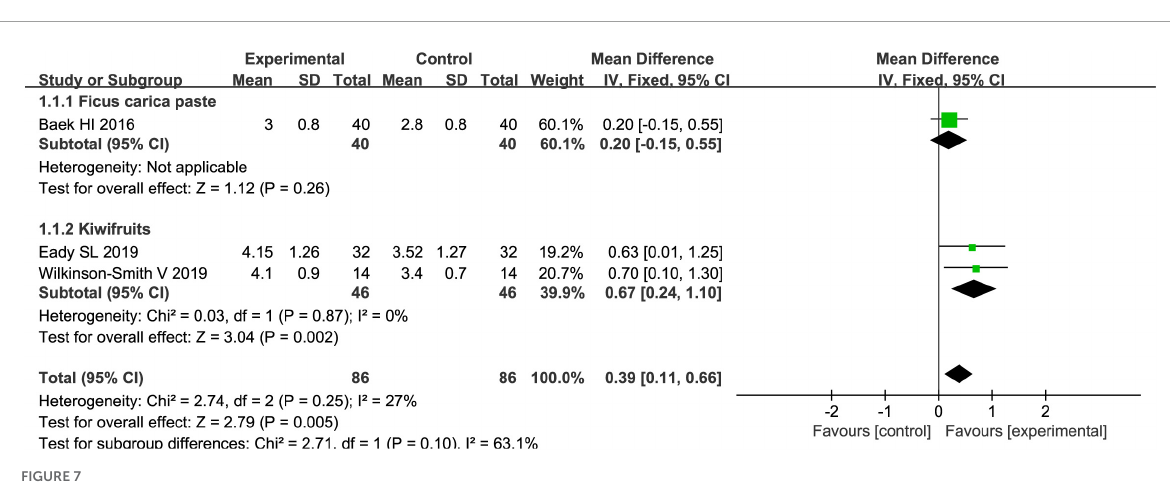
FIGURE7 Intervention effect of different types of fruits vs. placebo for Bristol stool score on patients in subgroup